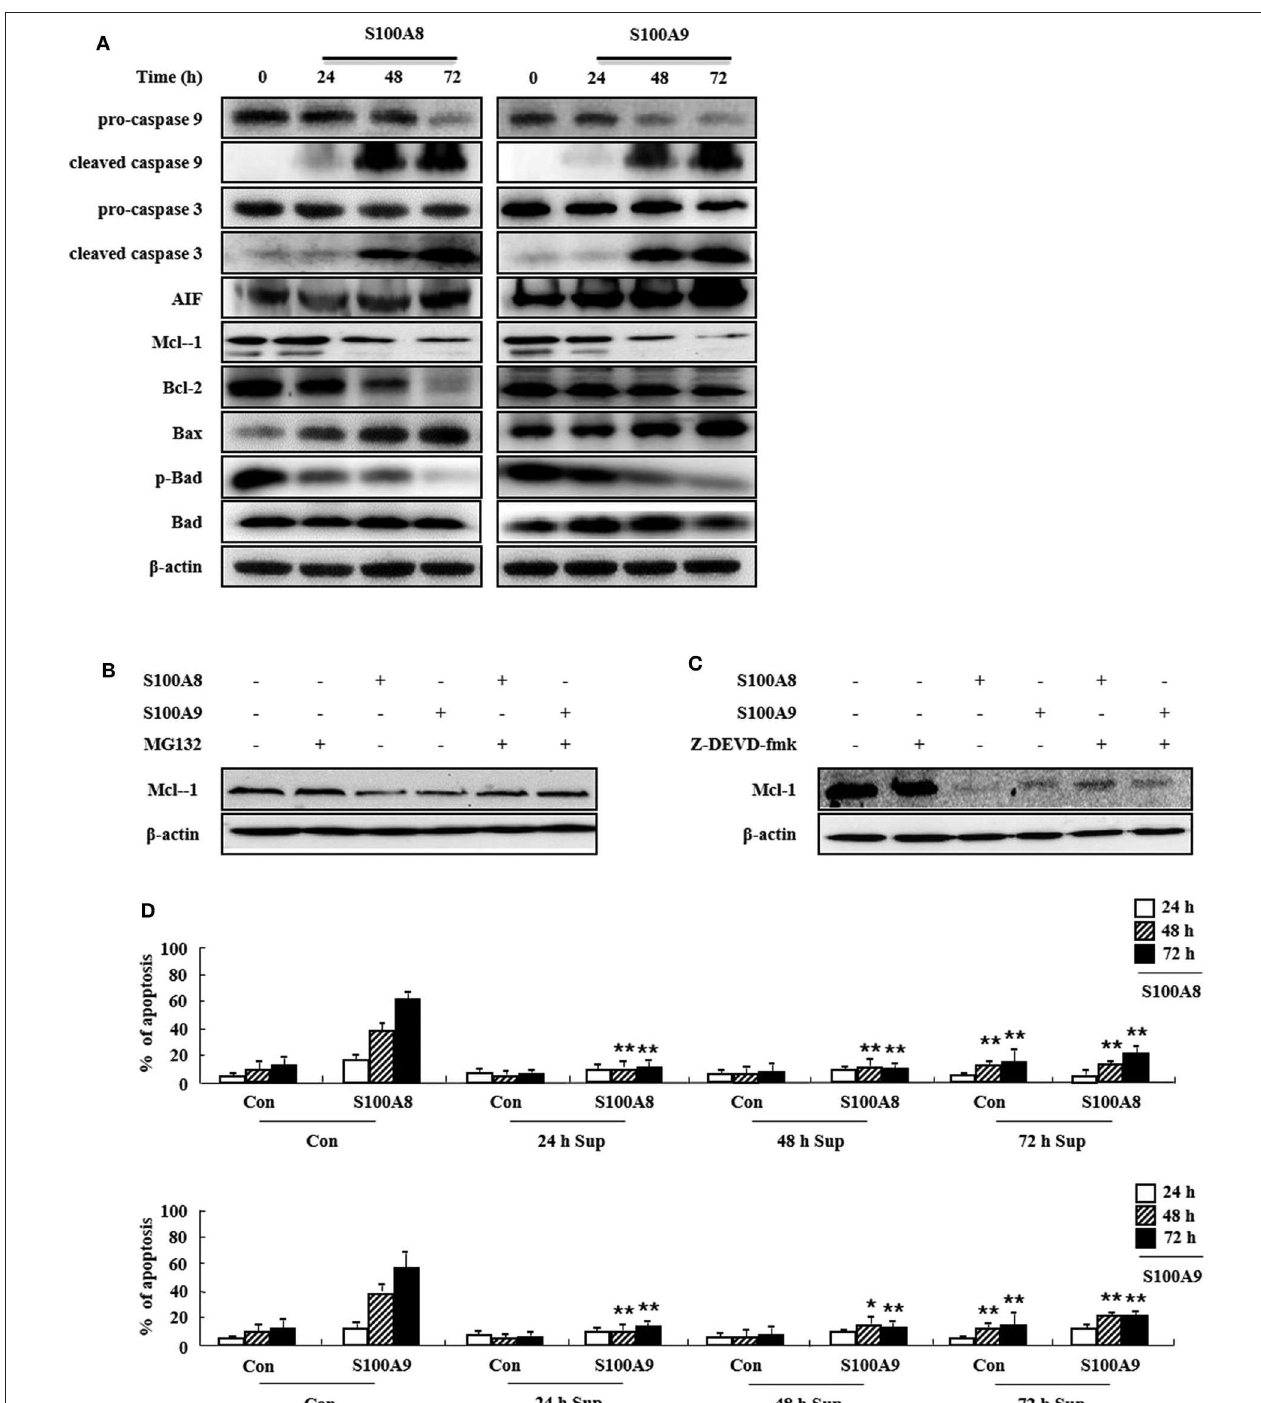
FIGURE 3 | S100A8 and S100A9 are required for the mitochondrial apoptosis pathway. (A) EoL-1 cells were incubated with S100A8 and S100A9 (10 µ g/mL) for 24, 48, and 72h. After cell lysis, the pro-caspase 9, cleaved caspase 9, pro-caspase 3, caspase 3, cleaved caspase 3, AIF, Mcl-1, Bcl-2, Bax, phospho-Bad, and Bad in the lysates were detected by Western blotting. (B,C) EoL-1 cells were pretreated with or without 0.5 µ M MG132 (B) and 10 µ M z-DEVD-fmk (C) for 1h, followed by incubation with S100A8 and S100A9 (10 µ g/mL) for 48h. Levels of Mcl-1 in the cell lysates were detected by Western blotting. β -actin was used as an internal control. (D) EoL-1 cells were incubated with S100A8 and S100A9 (10 µ g/mL) for 24, 48, and 72h, and supernatants were collected at appropriate time points. EoL-1 cells were incubated with S100A8 and S100A9 (10 µ g/mL) for 24, 48, and 72h in the absence or presence of the supernatant ( n = 3). Apoptosis was analyzed by measuring the binding of annexin V-FITC and PI. * p < 0.05 and ** p < 0.01 indicate a significant difference between the control and stimulator-treated groups.